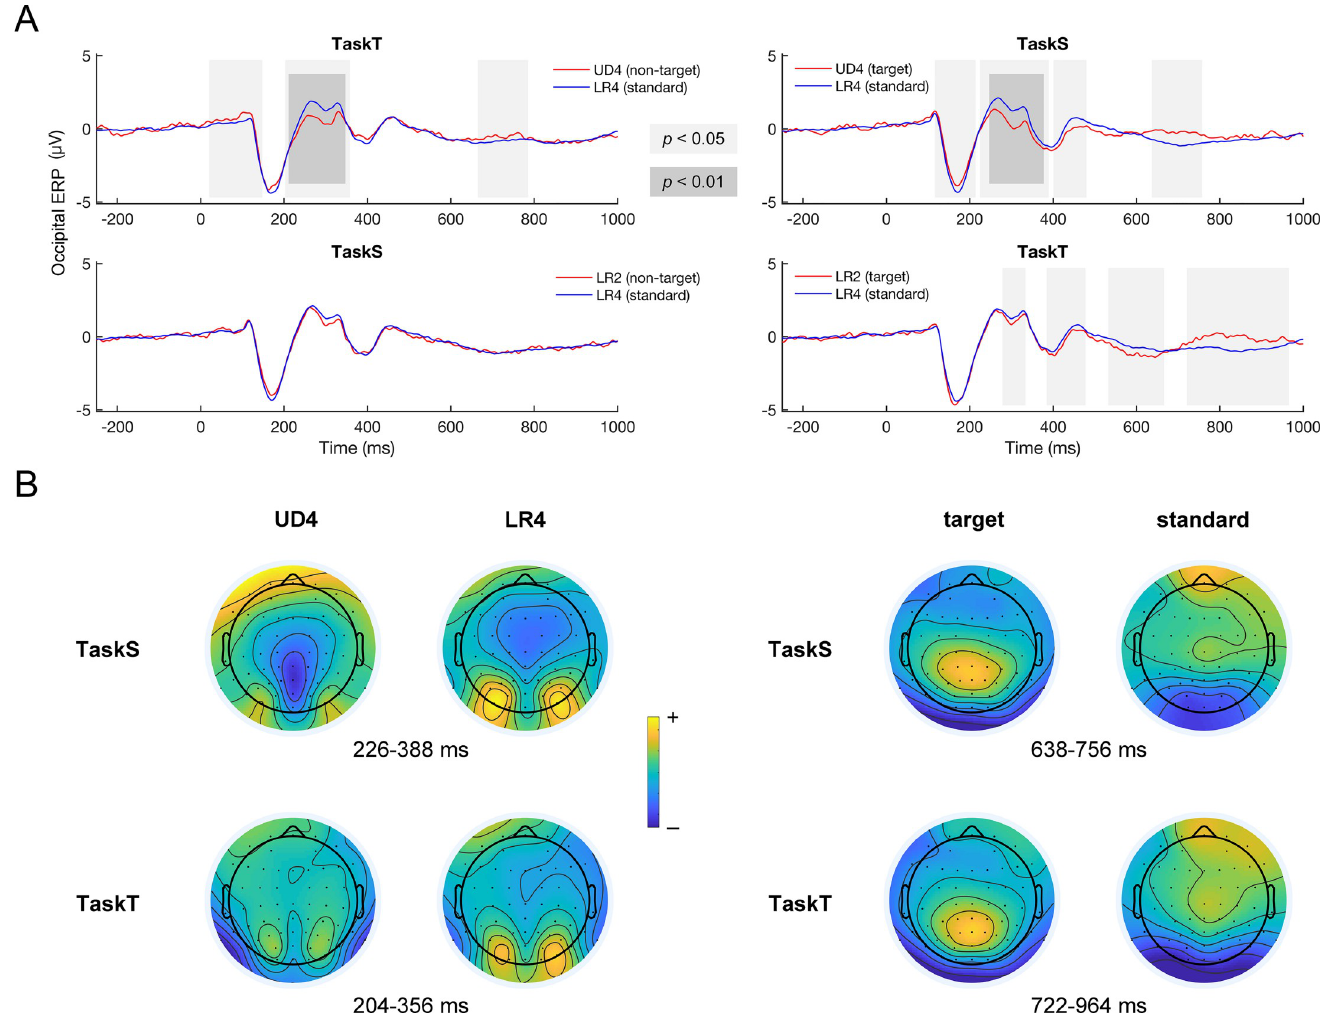
Fig 3. Occipital ERPs. (A) Responses recorded at occipital electrodes. Significant differences in occipital ERPs in response to standard and non-target stimuli in TaskT were observed, especially within the time range of P200. Similar response differences were also observed in TaskS between occipital ERPs in response to standard and target stimuli. These findings suggest that the abstract structural pattern could be detected explicitly and implicitly. In contrast, no significant difference in occipital ERPs in response to standard and non-target stimuli in TaskS was observed, but there were significant differences in occipital ERPs in response to standard and target stimuli in TaskT, suggesting that the abstract tonal pattern could only be detected if conscious attention was paid to the tonal feature of characters. (B) Topographies of the occipital P200 and parietal P300 components. The topographies of the occipital P200 component suggest that the difference effects indeed arose from the occipital lobe. The parietal P300 effects occurred primarily around Pz, although occipital ERPs also showed similar effects that may partially be a product of volume